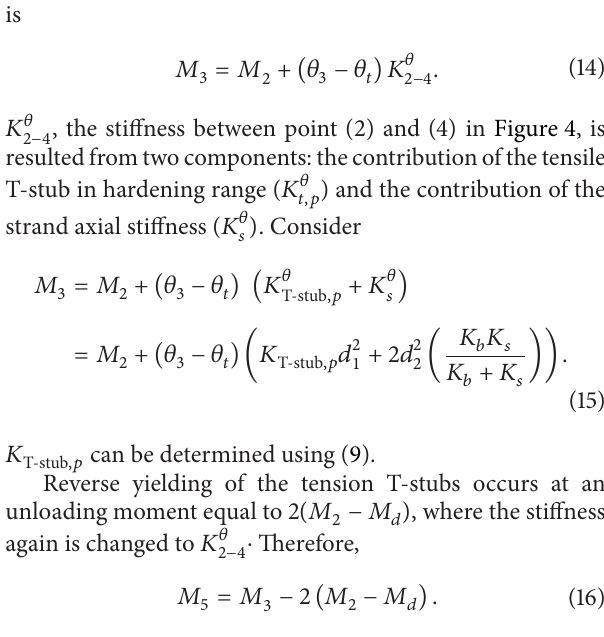
Figure 4: Moment-rotation behavior of posttensioned connection.